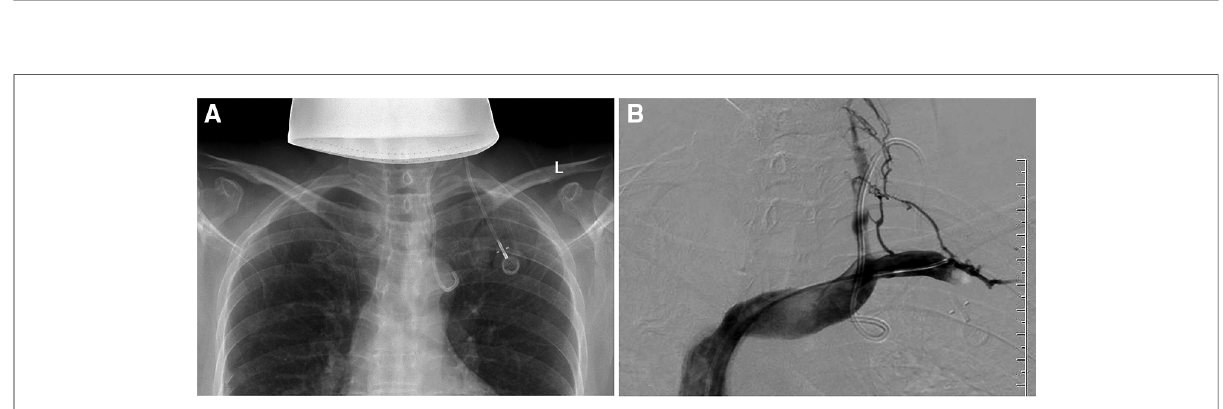
FIGURE 3 Catheter malposition to internal thoracic vein. ( A ) The chest x -ray suspected that the catheter was not in the SVC; ( B ) Injected the contrast medium through the port, the catheter was located in the internal thoracic vein, and part of the contrast medium fl owed back into the SVC (arrow).